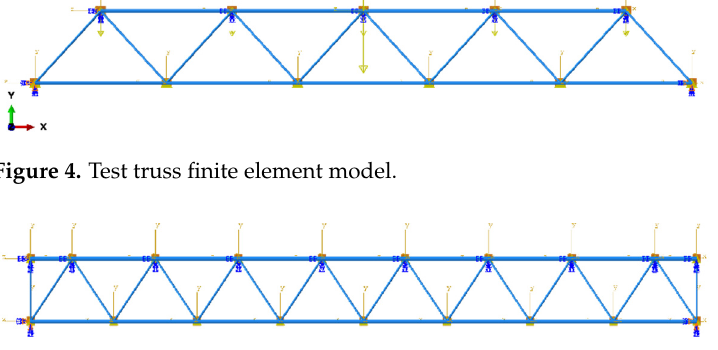
Figure 5. Steel roof truss finite element model.